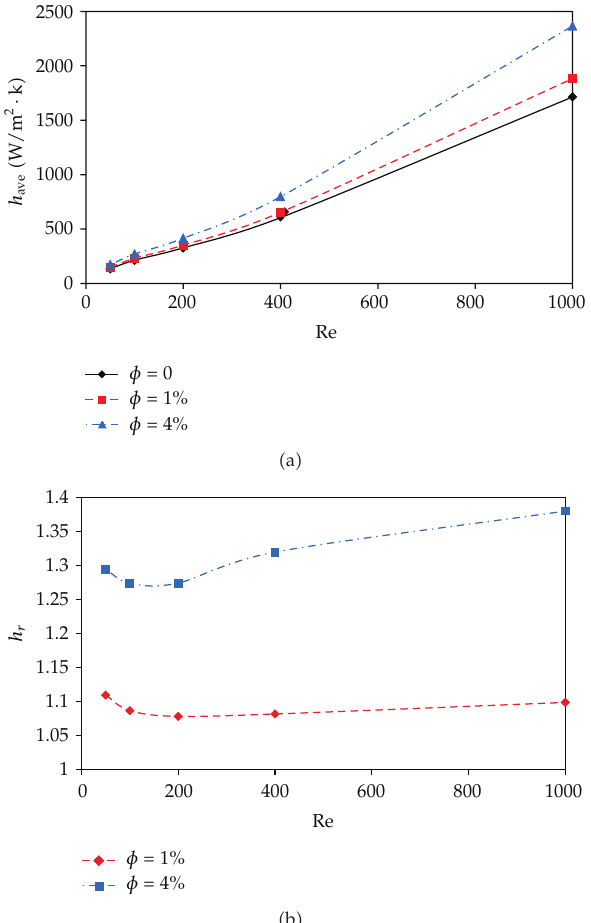
Figure 8: E ff ect of parameters φ and Re on: (cid:3) a (cid:5) average heat transfer coe ffi cient and (cid:3) b (cid:5) average heat transfer coe ffi cient